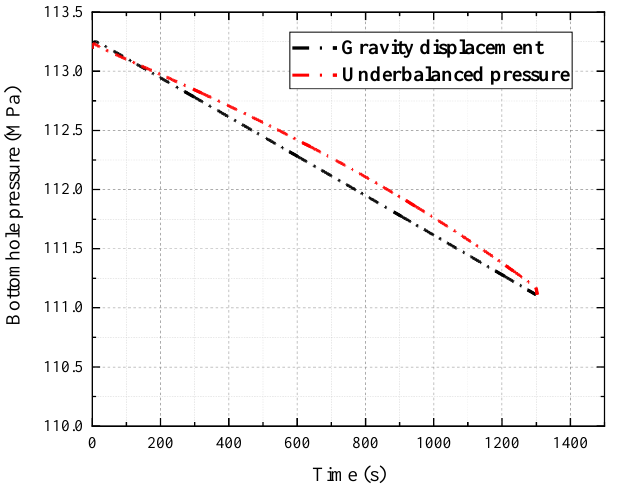
Figure 4. Comparison of the changes in the bottomhole pressure for well M.